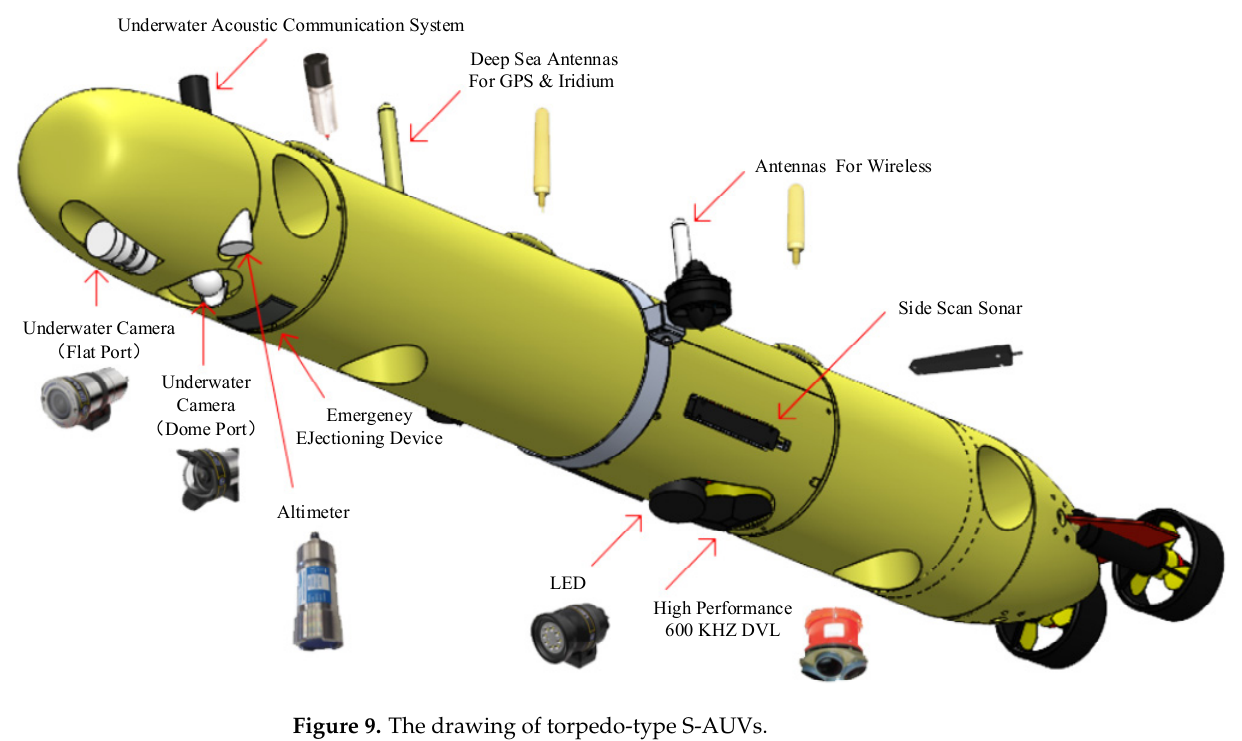
Figure 9. The drawing of torpedo-type S-AUVs.